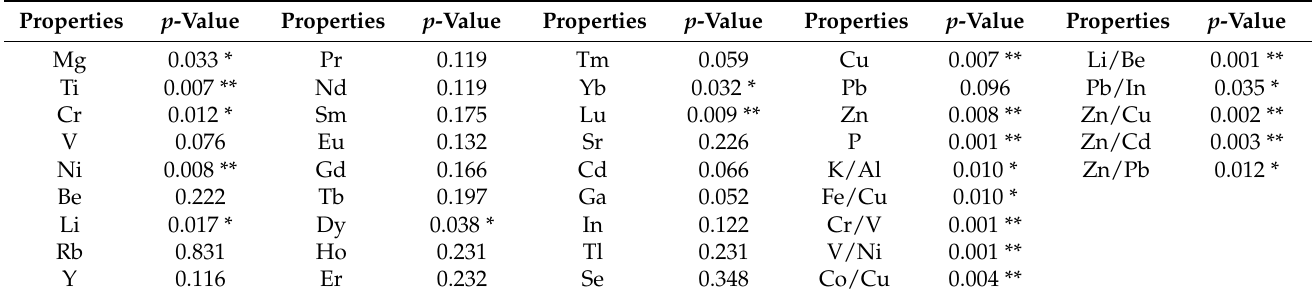
Table 4. Results of KW-H test for performance of each property of source group 1.